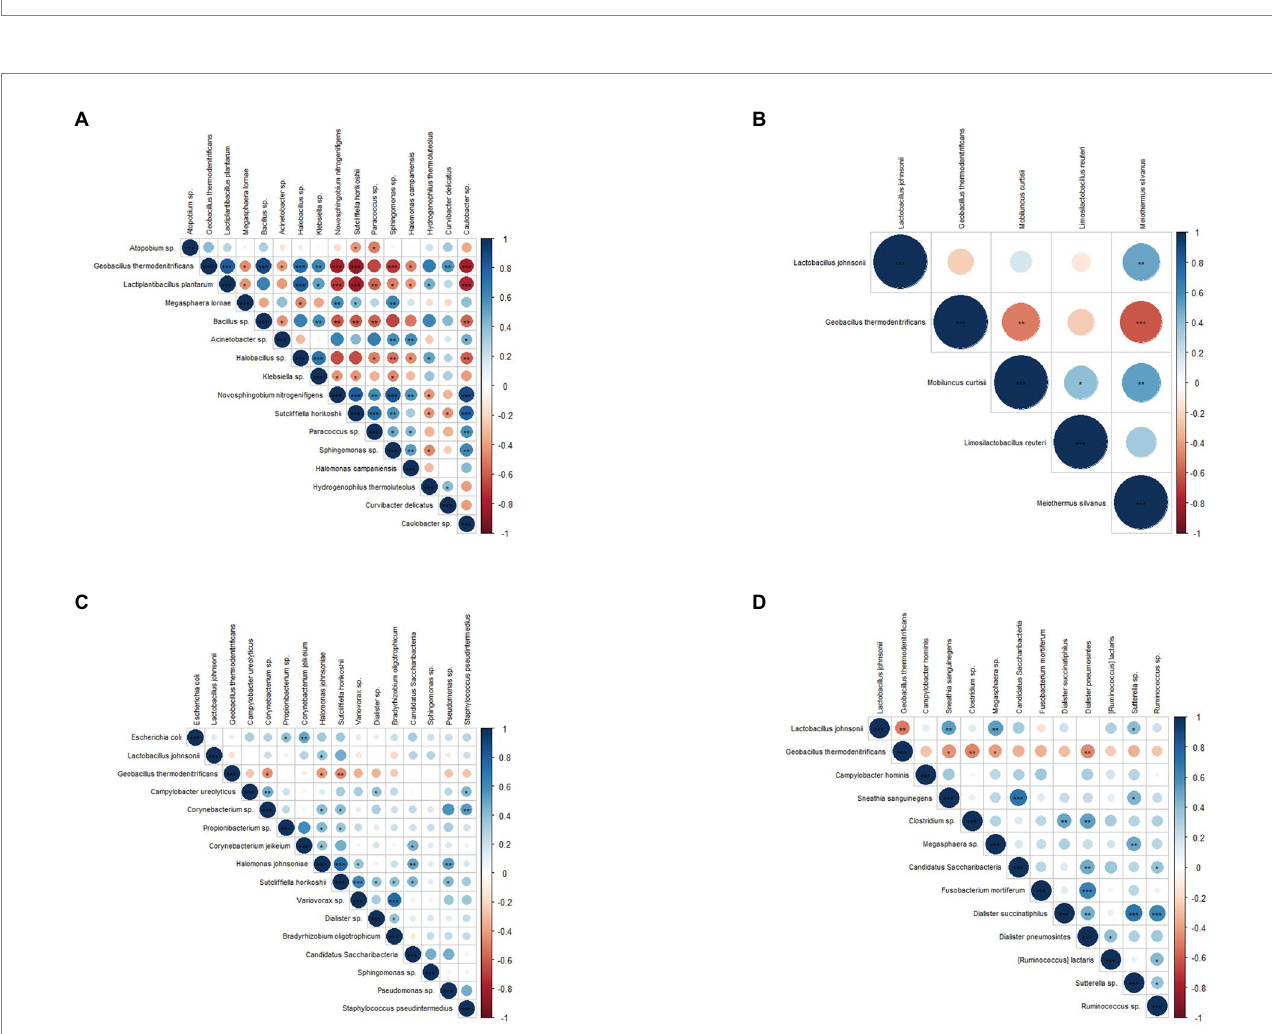
FIGURE 4 Correlation analysis of microbial markers between different sampling sites. (A) Spearman’s rank correlation analysis of microbial markers in the cervix, (B) in the vagina, (C) in the urethra, and (D) in the intestine. Blue indicates positive correlation, red indicates negative correlation, p values represented as * p < 0.05, ** p < 0.01, *** p <